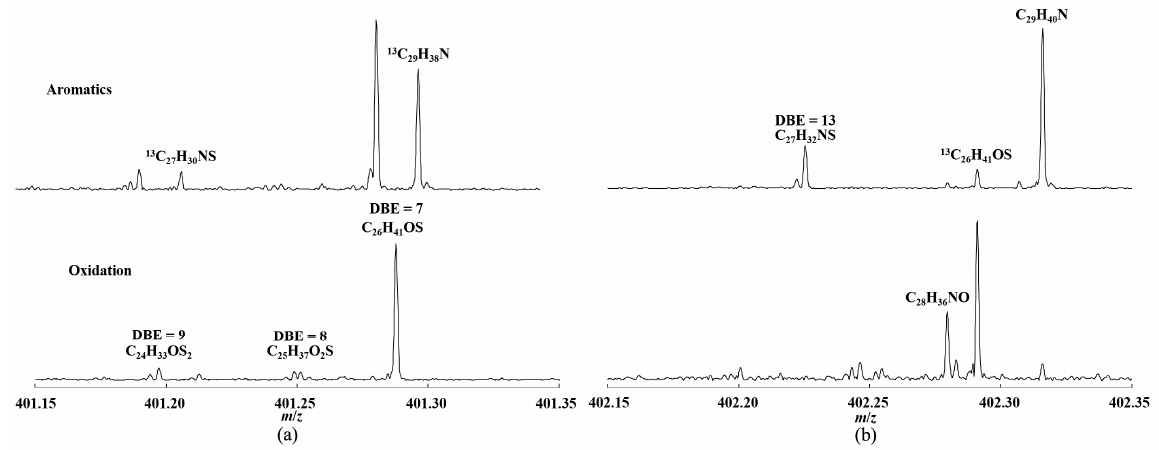
Figure 2. The local enlarged map of LGAR aromatics mass spectrum: ( a ) m/z = 401; ( b ) m/z = 402.